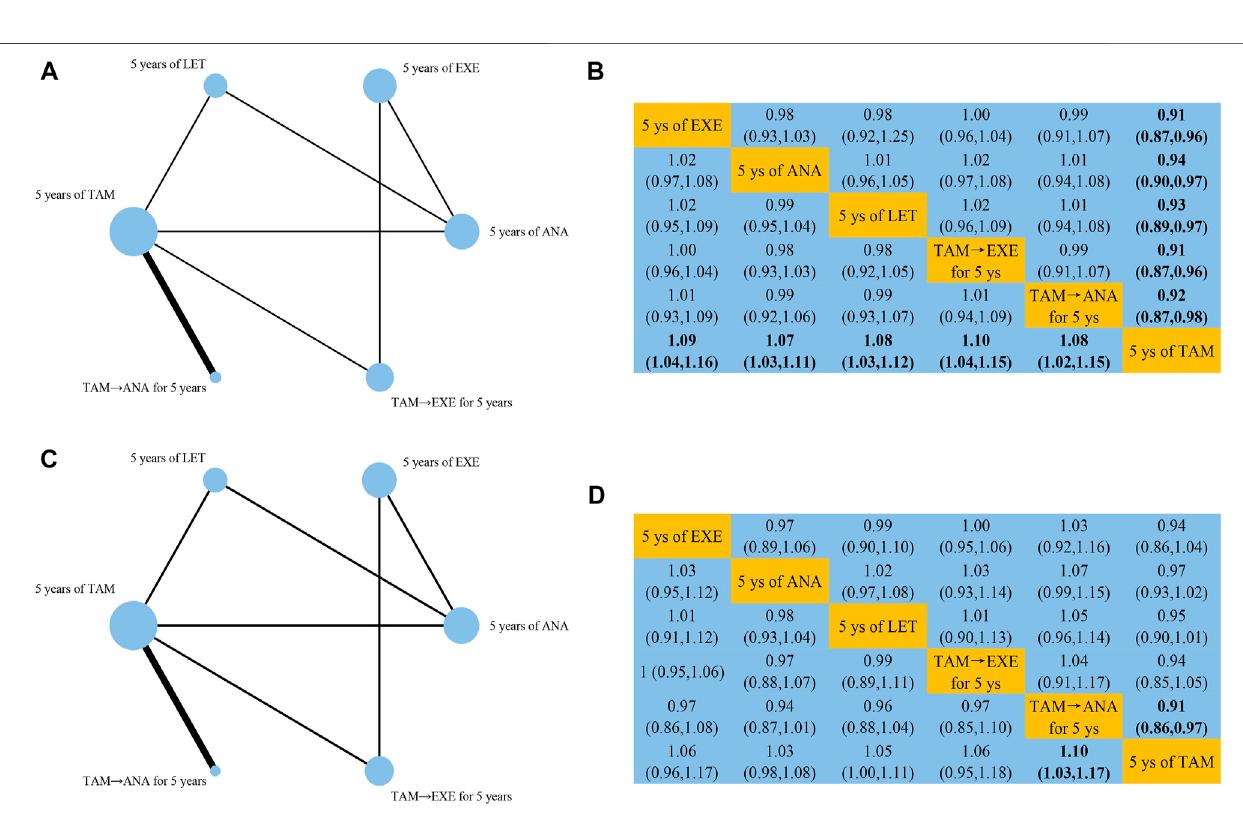
FIGURE 4 | Network structure diagrams and league tables for (A,B) DFS and (C,D) OS. Abbreviations: EXE, exemestane; ANA, anastrozole; LET,